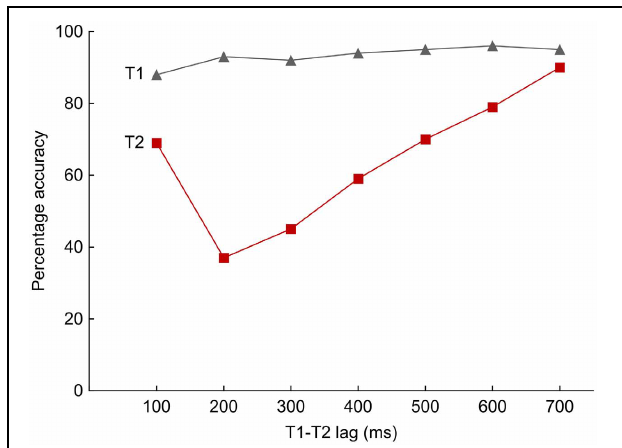
FIGURE 1 | A typical performance pattern in a dual-target rapid serial visual presentation task (i.e., an attentional blink task). The temporal distance between the two targets and the number of intervening distractors vary and result in different lag times. At a presentation rate of 10Hz, a temporal separation of 100ms contains no distractor, while at the 700-ms lag six distractors are embraced by the first and second targets (T1 and T2, respectively). The red curve displays the accurate T2 report given correct T1 identification as a function of lag times. Observers particularly often miss T2 if it falls in a window between 200 and 300ms after T1, but dual-target report improves at longer lags. In many instances, superior accuracy translates to the earliest interval (100ms), where T1 and T2 follow each other immediately. Single T1 report is shown in gray and is usually close to ceiling across lag